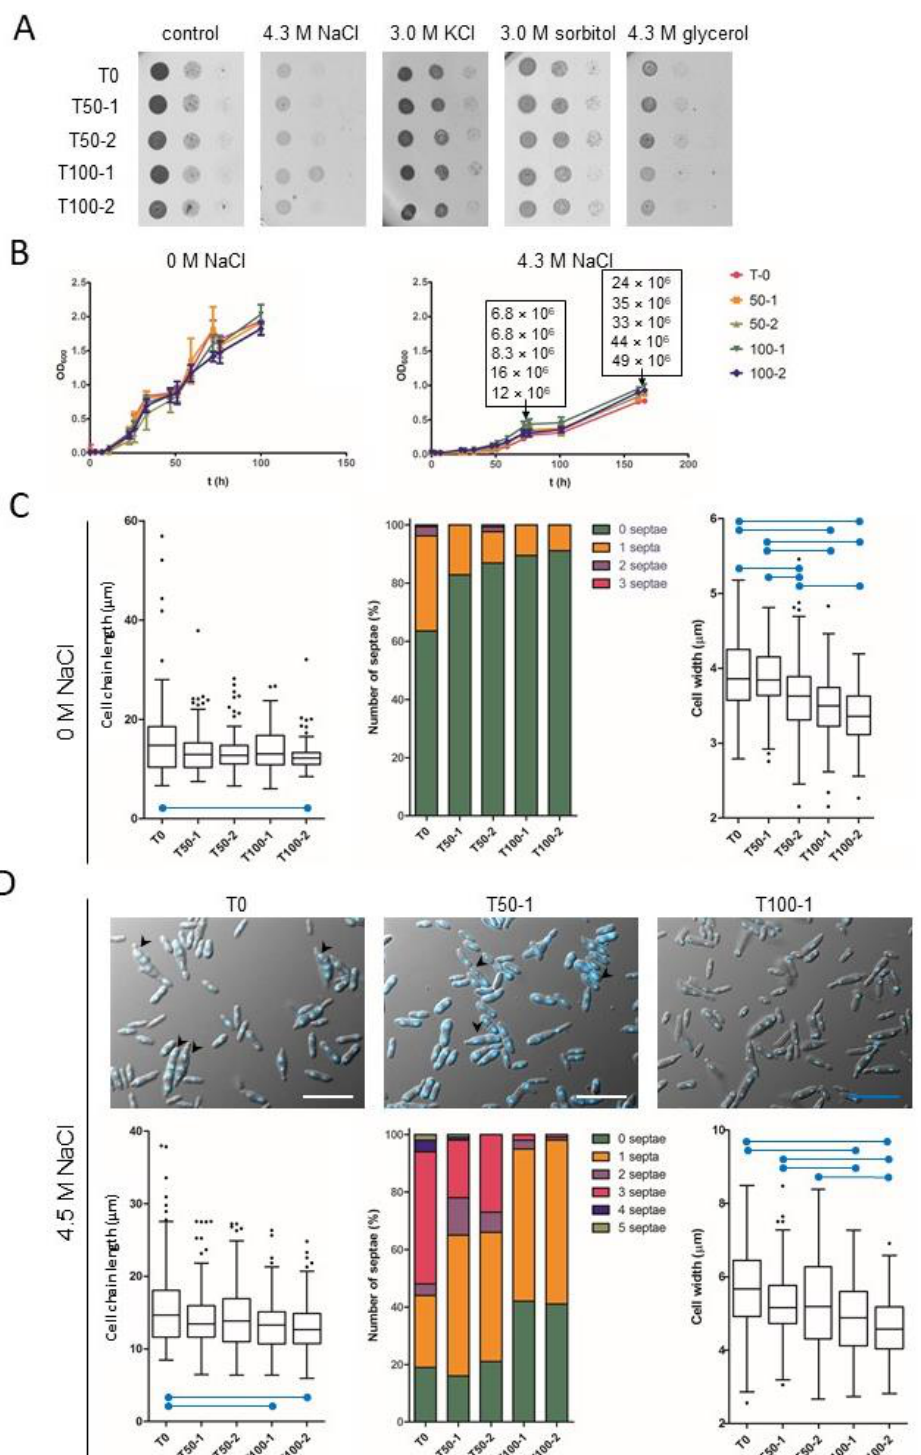
Figure 1. Growth rate and morphology of Hortaea werneckii during experimental evolution at